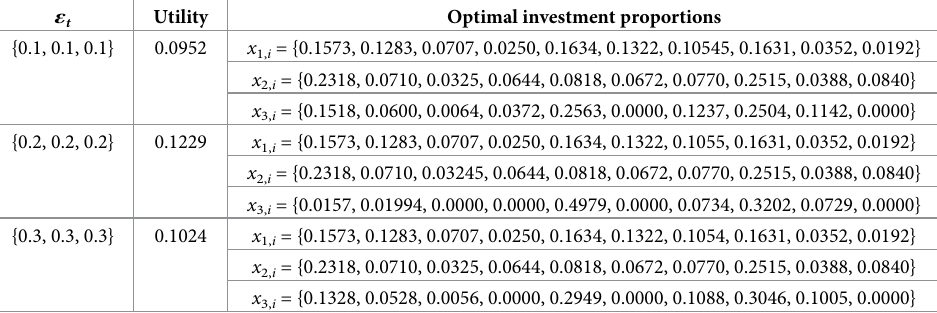
Table 4. Proportion of each security under different belief degree of